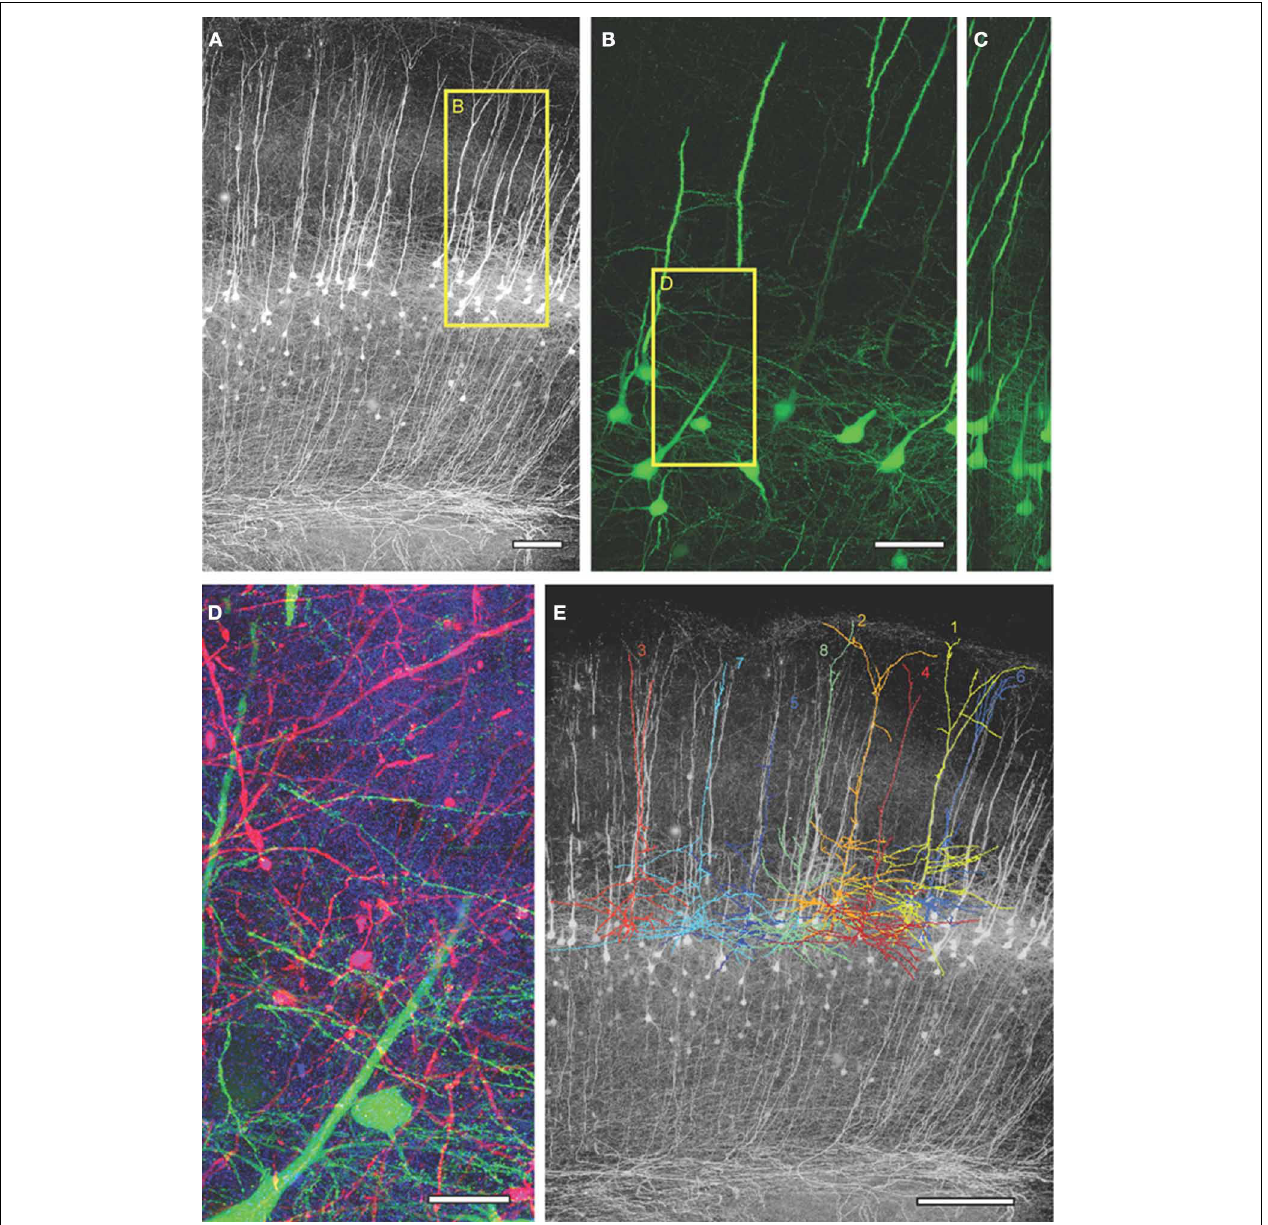
FIGURE 2 | Large-scale array tomography images from barrel cortex of Thy1-YFP h mouse. (A) Maximum intensity projected YFP image from the aligned image stack obtained from 1074 serial sections. (B) Maximum intensity projection of 300 serial sections ( = 60 µ m thick) from the box in (A) showing YFP-expressing L5 pyramidal neurons. (C) Orthogonal y - z view of